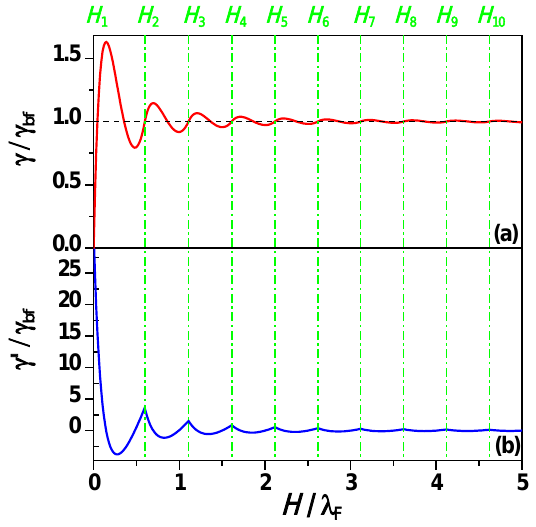
Figure 1. (A) Surface free energy γ , and (b) first derivative γ ’ versus nanofilm thickness H from Equation (2). Dashed black horizontal line in (a) corresponds to bulk film surface free energy γ and green dash-dotted vertical lines represent H bf from [67] (Copyright American Physical Society